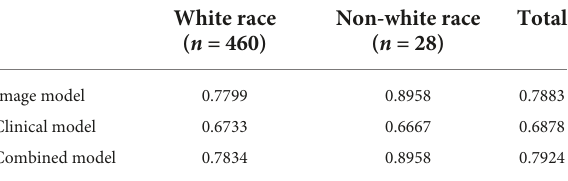
TABLE 4 Performance/AUC for each model on white vs. non-white races on a small test dataset ( n = 488). White race ( n =